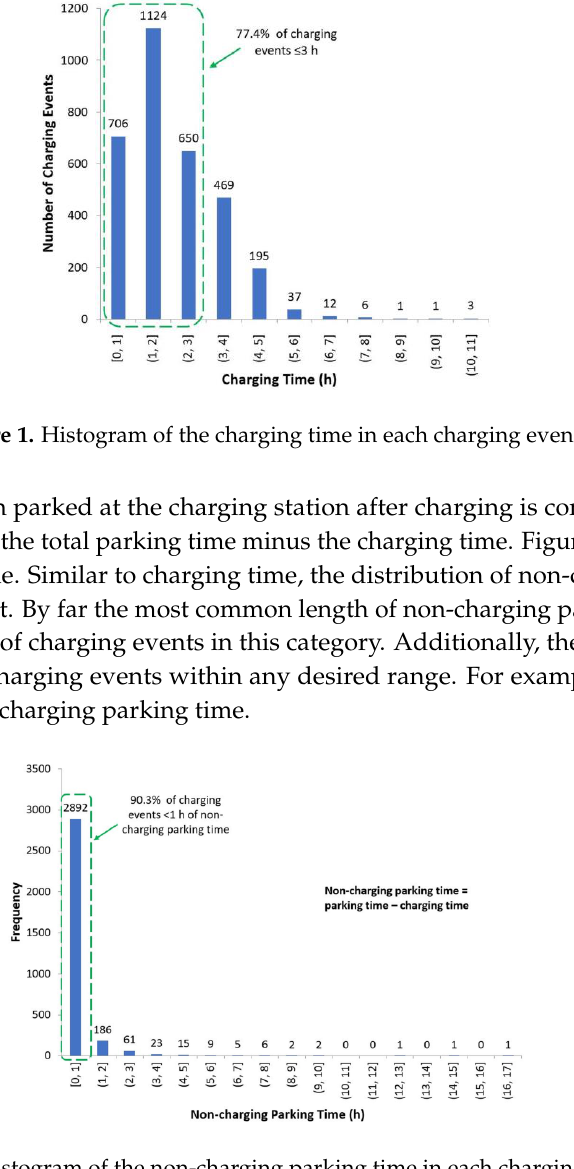
Figure 2. Histogram of the non-charging parking time in each charging event.